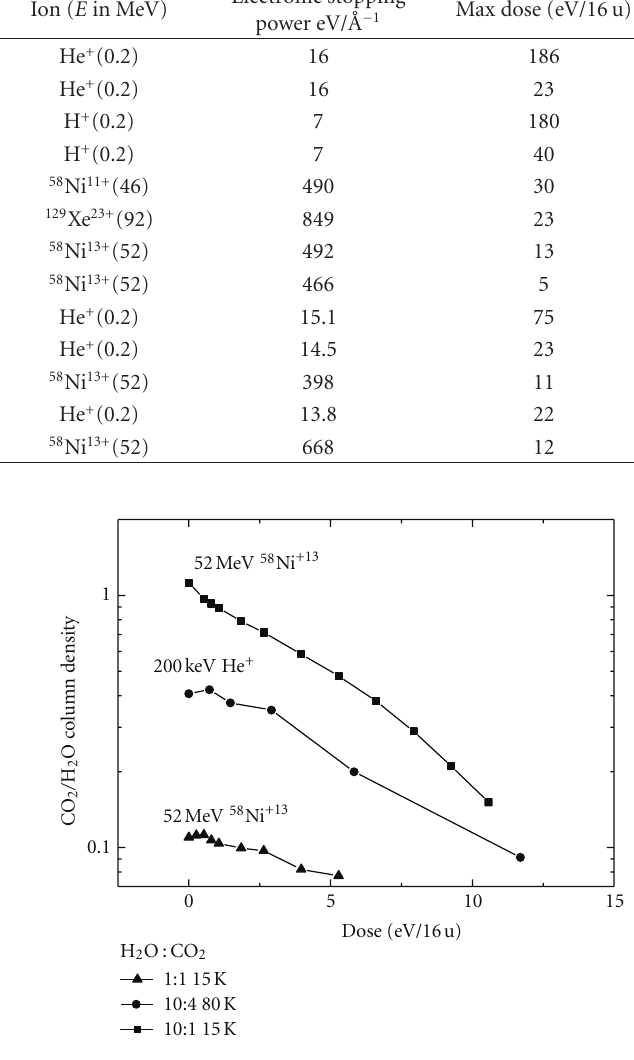
Figure 1: The column density ratio (CO 2 / H 2 O) of three di ff erent mixtures at 15 or 80 K, is reported versus the dose su ff ered after irradiation with He + or Ni 13+ ions having di ff erent